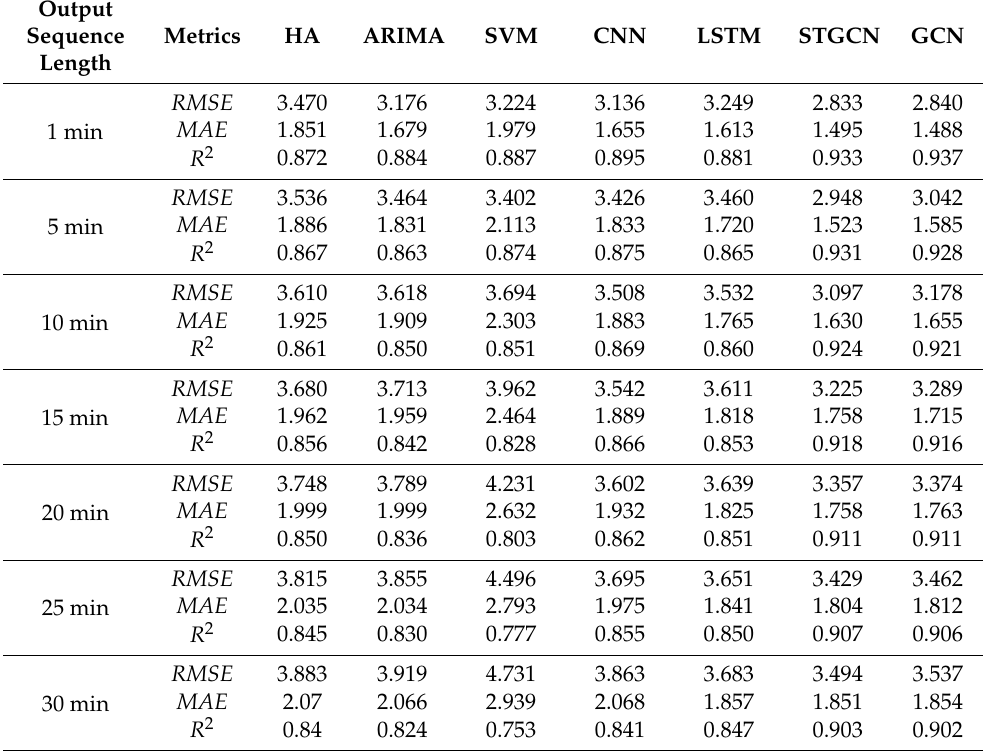
Table 4. The performances of different